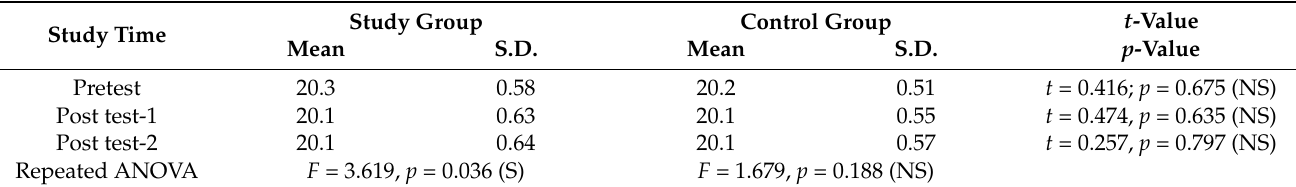
Table 1. Comparison of BMI Status among Study and Control